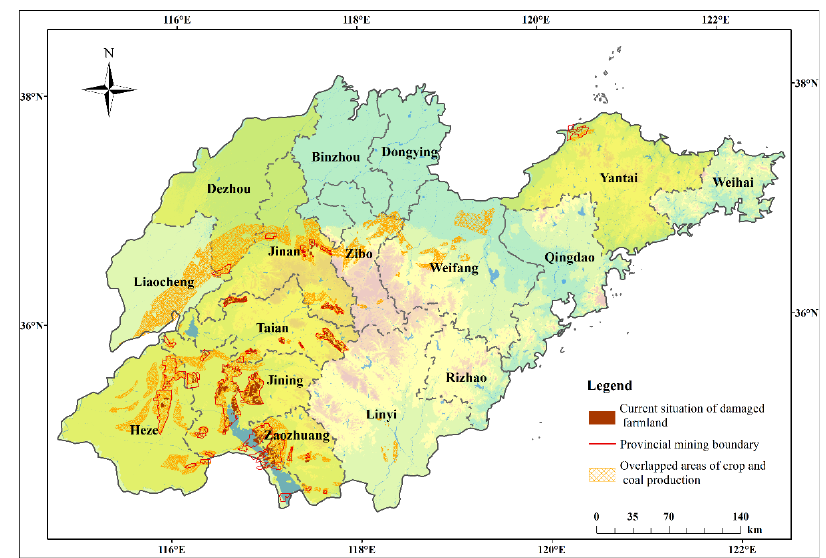
Figure 3. Current distribution of damaged farmland. Table 2. Current area of damaged farmland.